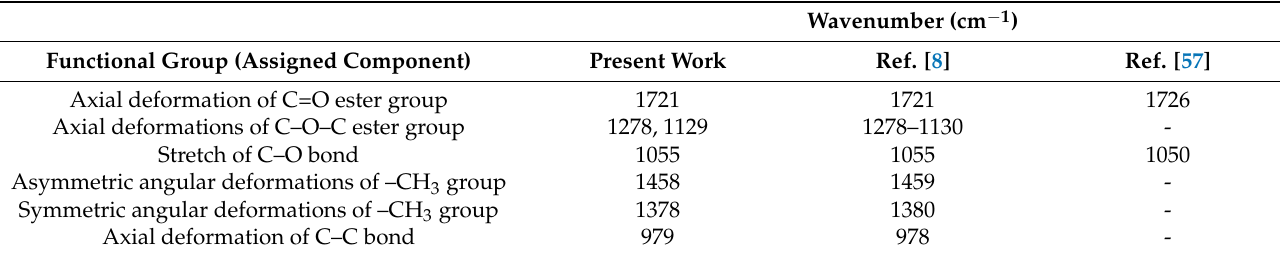
Figure 5. ( a ) FTIR spectra and ( b – d ) TGA/DTG curves of PHB/AgNPs, PHB/PEG/AgNPs, and PHB/PEG/ALG-e/AgNPs films. Table 3. Position of the IR bands found for the analyzed films.